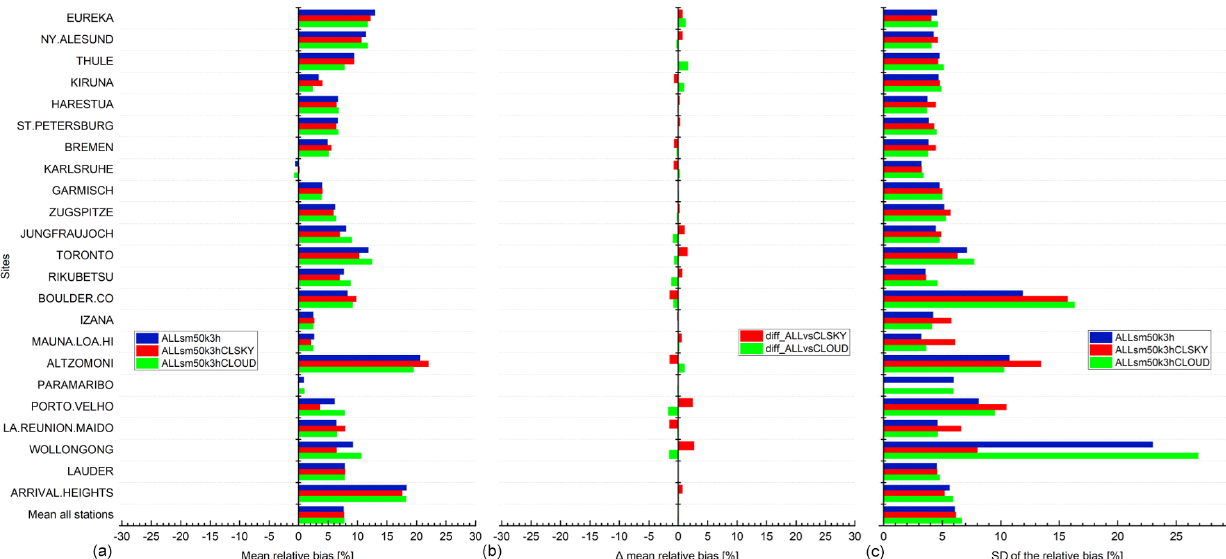
Figure 34. S5P CO column (ALL, CLSKY and CLOUD cases) validation results against NDACC CO column data at 23 stations within the period between November 2017 and September 2020. (a) Bar chart of mean relative bias ((SAT – GB)/GB) in percent; (c) standard deviation of the relative bias in percent; (b) difference of the mean relative bias for validation cases (ALLsm50k3hCLSKY, ALLsm50k3hCLOUD) in percent against the reference case (ALLsm50k3h) in percent. Spatial co-location with radius of 50km and time co-location of ± 3h around the satellite overpass were used. The stations are sorted with decreasing